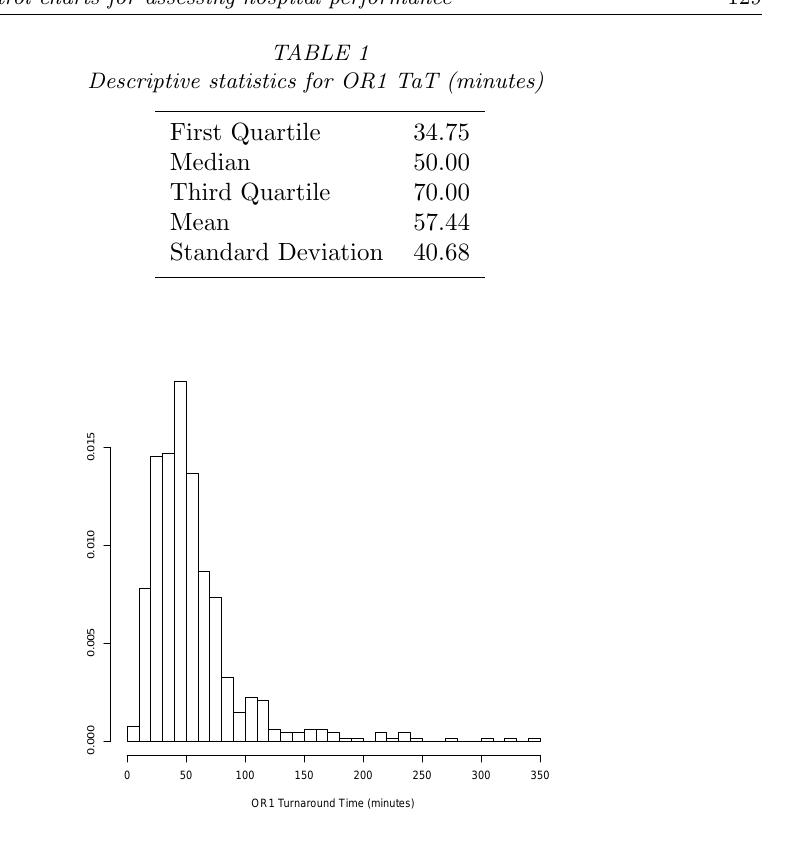
Figure 1 – Histogram of the operating room 1 TaT (minutes)